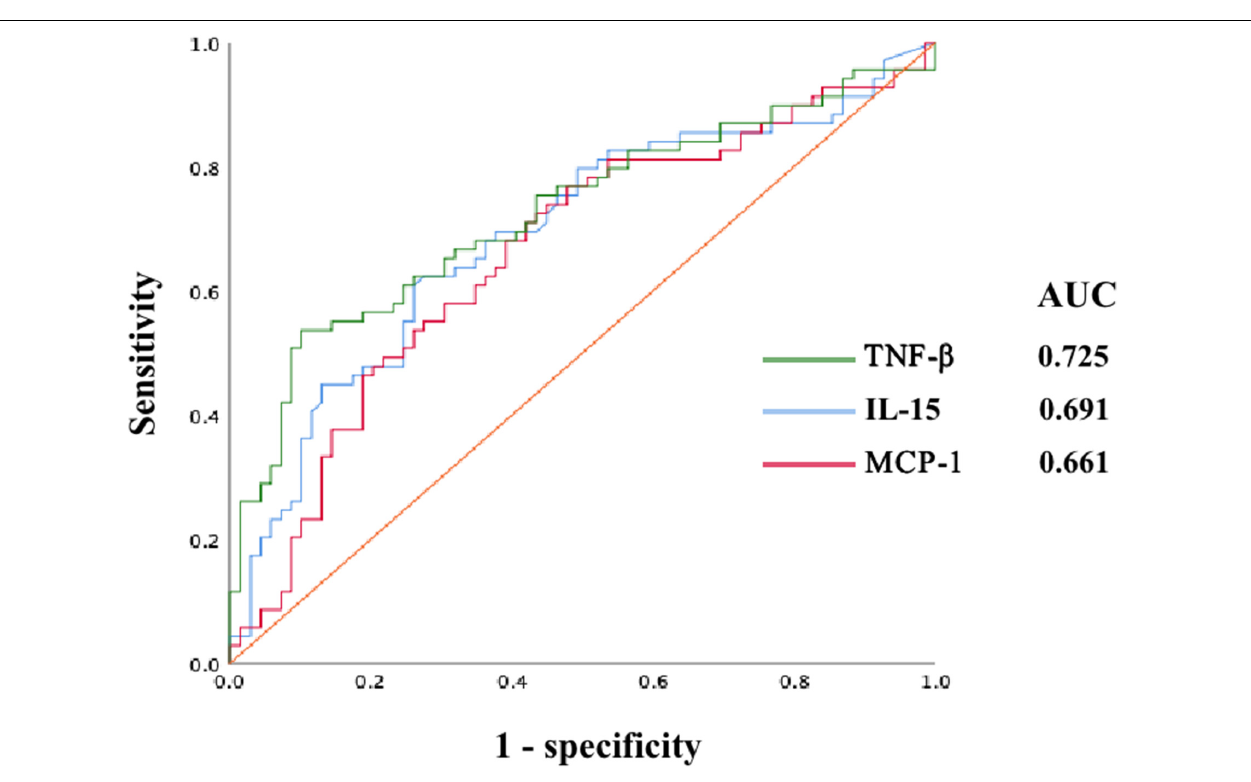
analysis was applied to measure the predictive ability of these cytokines for aneurysm progression. The results demonstrated that TNF- β achieved the highest predictive accuracy, with an AUC value of 0.725 (95% CI 0.639–0.811, P < 0.001) followed ( Figure 4 ). Based on the ROC curve, each cytokine’s cut-off value was calculated. As shown in Table 2 , higher risk of aneurysm growth was identified more frequently in patients with high levels of serum IL-15 (69.4 vs. 34.2%, P = 4.3 × 10 − 5 , cut-off